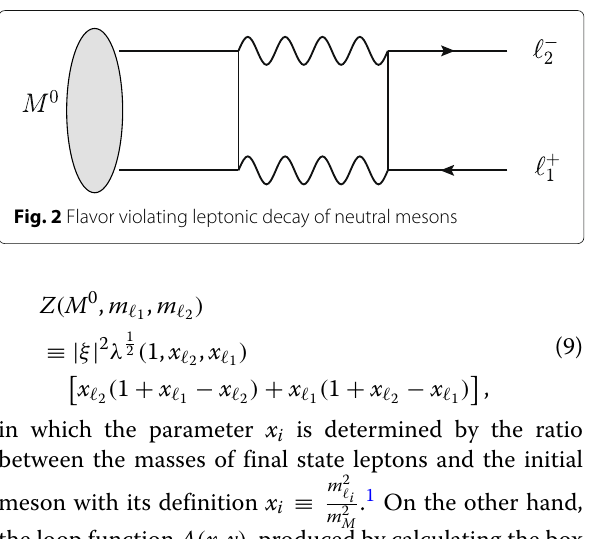
Table 2 The detailed parameters for semileptonic decay